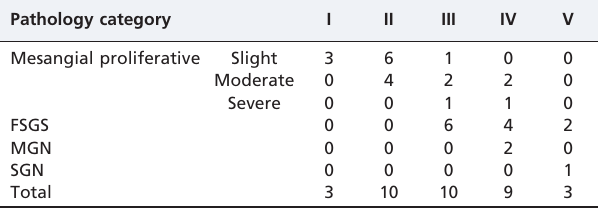
Table 2 - Brief summary of histologic changes in 35 cases of IgAN according to Lee 9 s classification